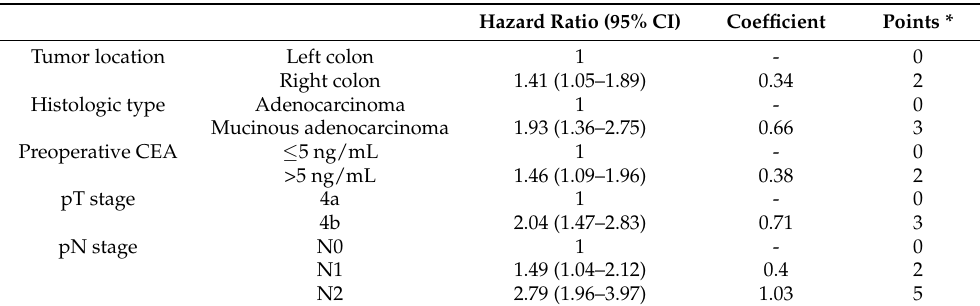
Table 3. Prediction model of metachronous peritoneal carcinomatosis risk and scoring system based on training set (N = 1503).